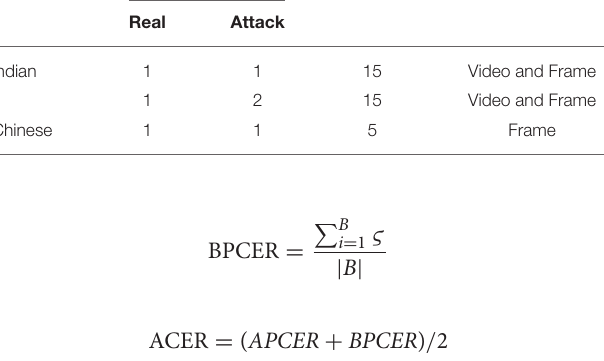
TABLE 2 | Protocol for the proposed Spoof-in-NIR database experiments.